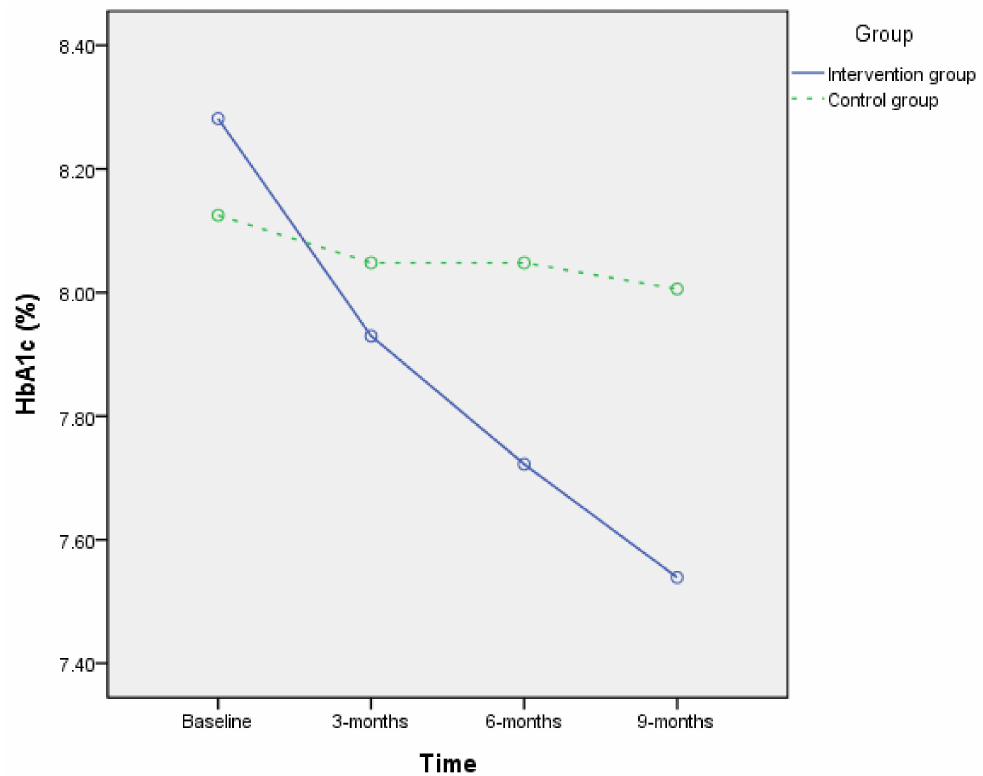
Figure 2. Effect of intervention within 9 months on HbA1c. Intervention group: solid line, control group: dashed line.